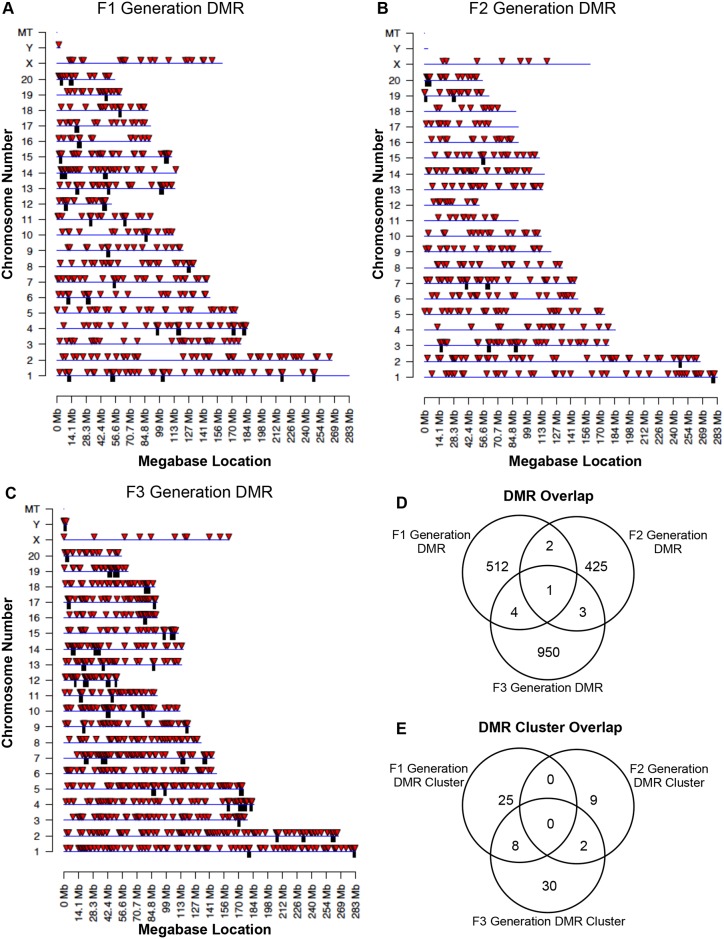
Chromosomal locations of DMR.Red arrowheads indicate DMR and black boxes represent regions with over-representation of DMR (i.e. cluster). (A) F1 generation sperm DMR locations on the individual chromosomes. All DMRs at a p-value threshold of 1e-06 are shown. (B) F2 generation sperm DMR locations on the individual chromosomes. All DMRs at a p-value threshold of 1e-05 are shown. (C) F3 generation sperm DMR locations on the individual chromosomes. All DMRs at a p-value threshold of 1e-09 are shown. (D) DMR overlap between the F1, F2 and F3 generation DMR. (E) DMR cluster overlap between the F1, F2 and F3 generation DMR clusters.